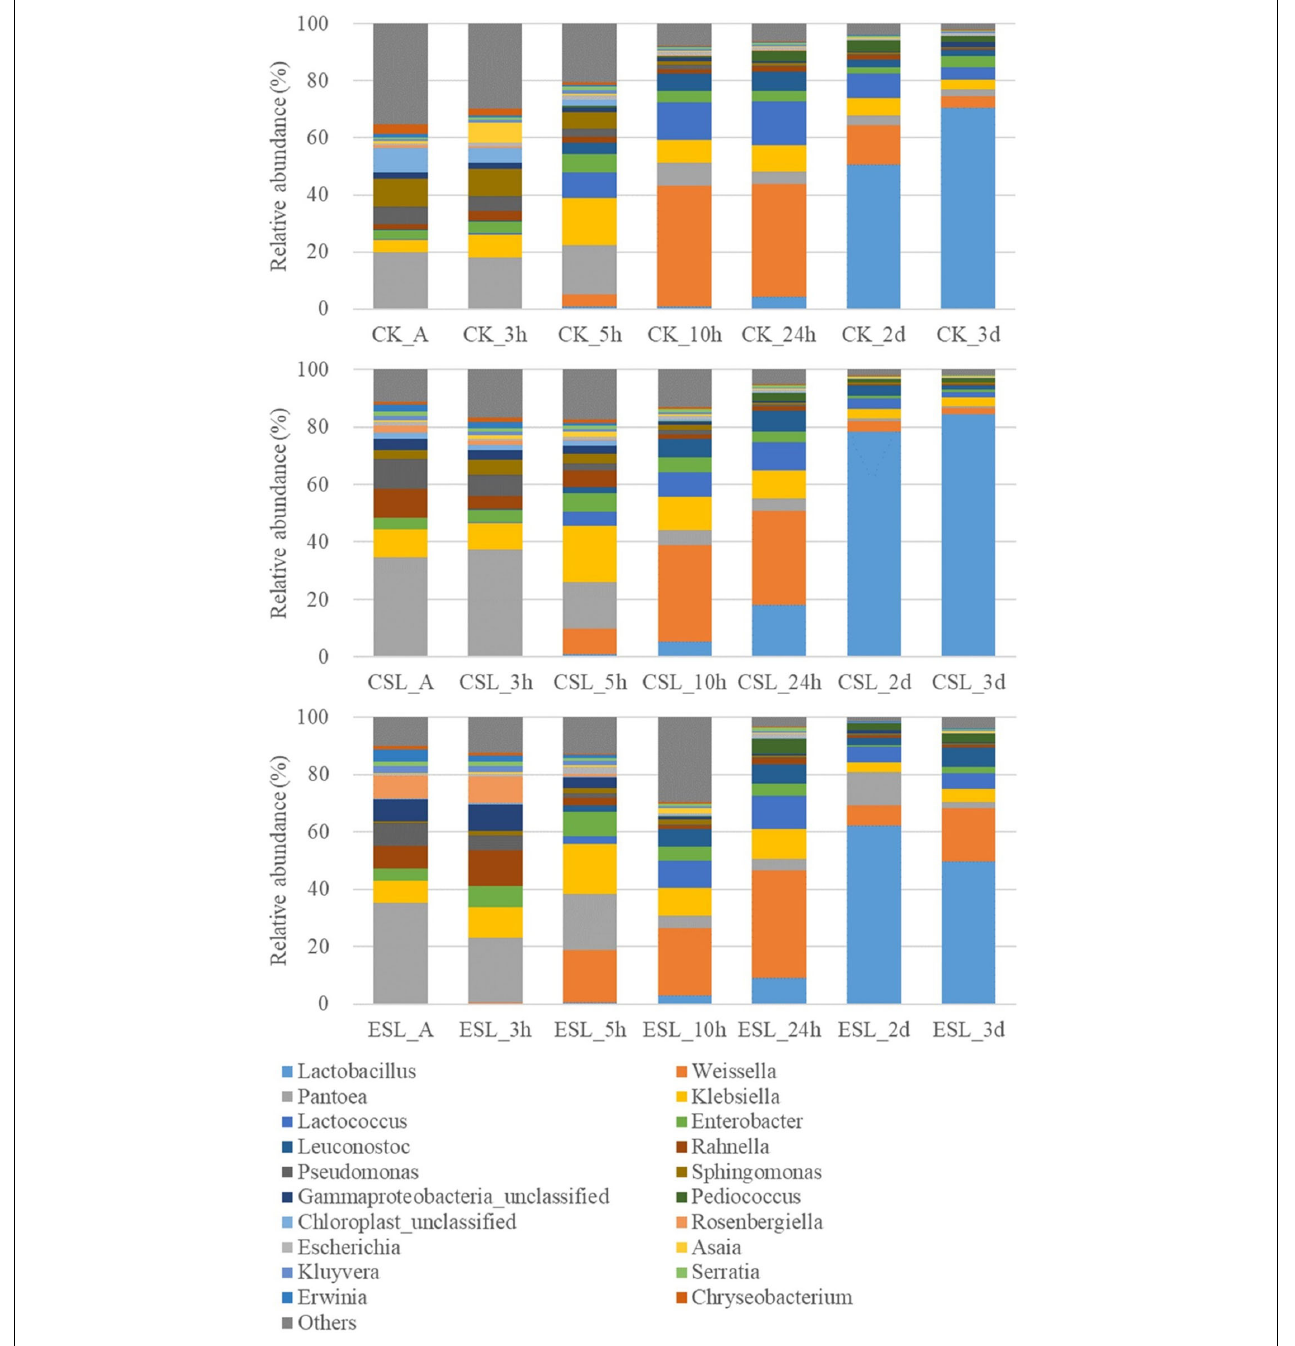
FIGURE 5 | Relative abundance of bacterial communities (genus level) in whole-plant corn silages during the intense fermentation phase. CK, whole-plant corn silage without any lactic acid bacterial suspensions; CSL, whole-plant corn silage treated with lactic acid bacterial suspensions prepared from whole-plant corn silage; ESL, whole-plant corn silage treated with lactic acid bacterial suspensions prepared from Elymus sibiricus silage; A, anaerobic